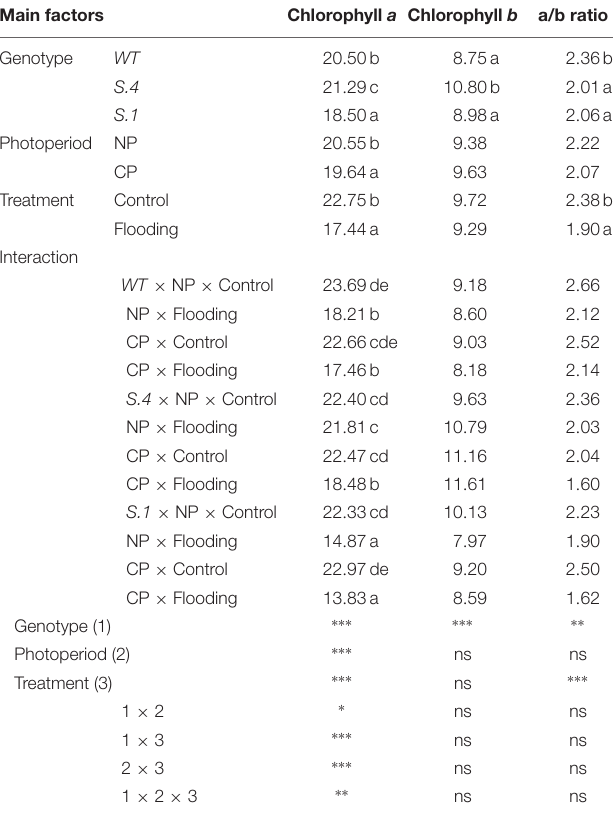
TABLE 1 | Level ( µ g cm − 2 ) of chlorophyll a , b, and a / b ratio in control, flooded-stressed Mr.S. 2/5- WT , and S.1 and S.4 plants at the end of the flooding